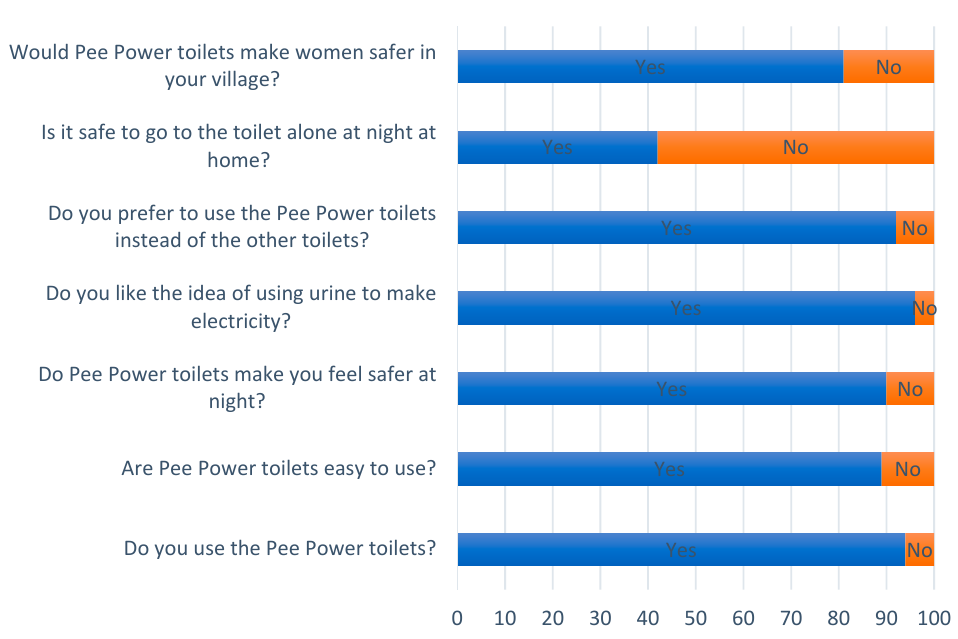
Figure 6. First post-installation (1 week of operation) questions and answers.